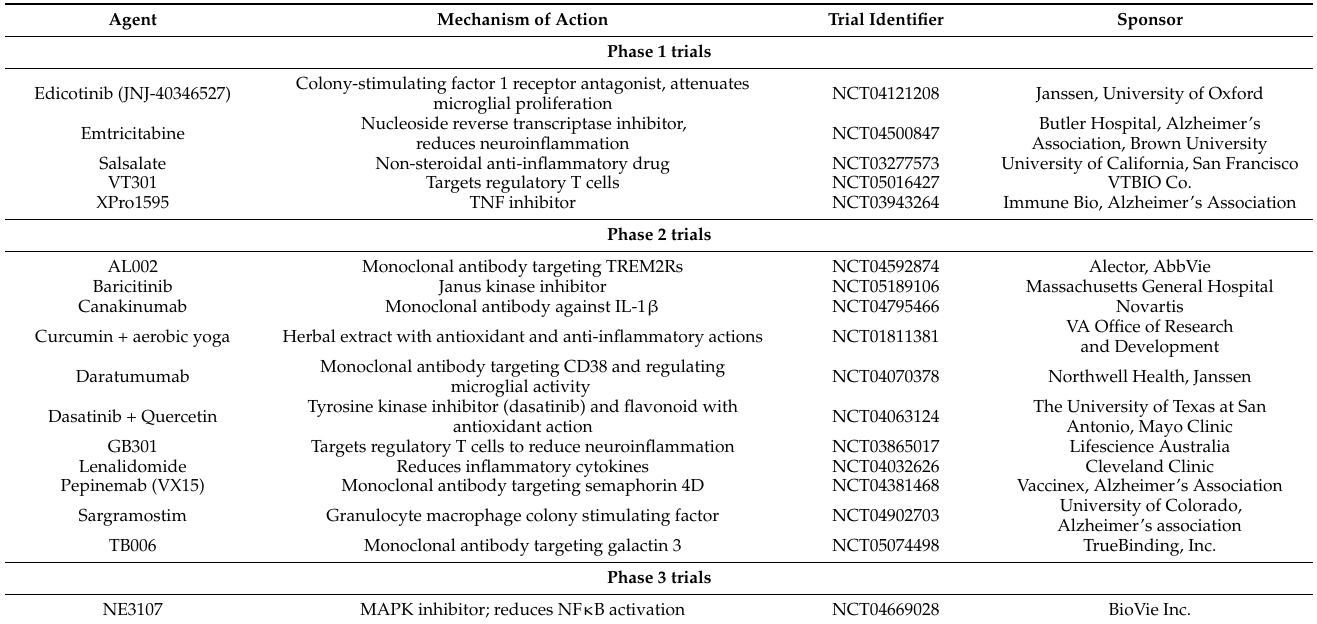
Table 3. Drugs in clinical testing phases targeting neuroinflammation